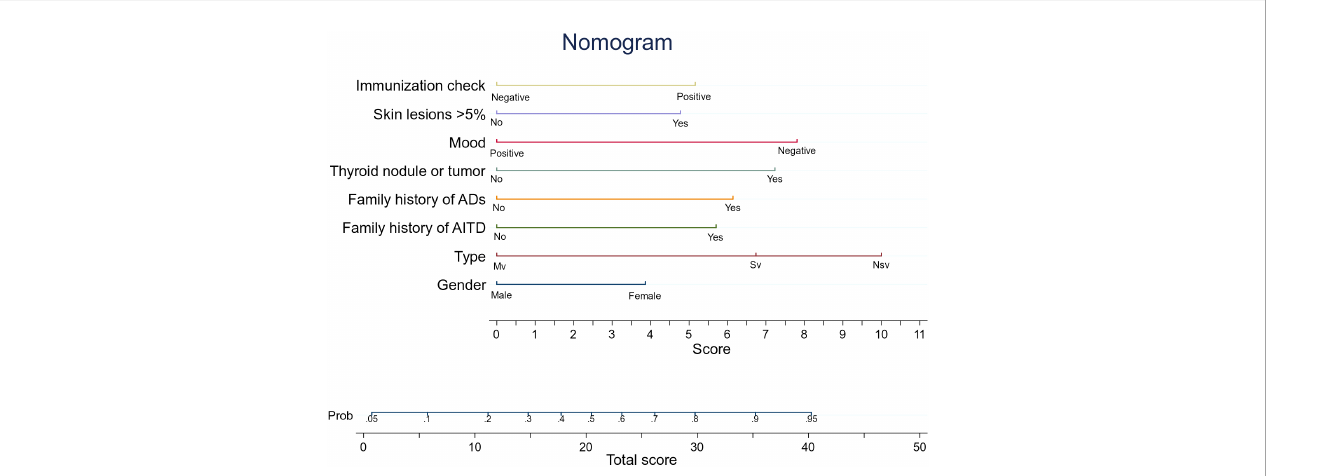
FIGURE 3 An AITD prediction line diagram may be developed in the queue based on a number of factors, including sex, vitiligo type, AITD family history, except for AITD autoimmune disease family history, thyroid nodules or tumors, and negative emotions. Involved skin area exceeds 5% of body surface area, and immunoglobulin plus tonic is positive. To calculate the probability that patients with vitiligo will develop AITD, draw a straight line on the point axis (for example, patients with non-segmental vitiligo will get 10 points). For each variable, repeat this process. Find the sum of the axis corresponding to each predicted variable. To determine the probability that patients with vitiligo will develop AITD, draw a line directly. For example, if a female patient with vitiligo has a family history of AITD, which is greater than 5%, and has a negative emotional type, then the prediction equation indicates that she has 53% chance of developing AITD. LASSO, Least Absolute Shrinkage and Selection Operator; AITD, autoimmune thyroid disease. The decision curve of the Hosmer – Lemeshow (HL) calibration curve predicts the nomogram, the area under the curve (AUC), and the risk of autoimmune thyroid disease (AITD).